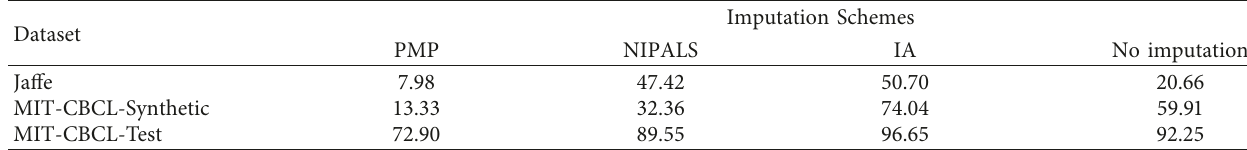
Figure 5: Jaffe (left), MIT-Synthetic (middle), and MIT-Test (right) at 100% distortion. Table 4: Model assessment at 100% distortion.